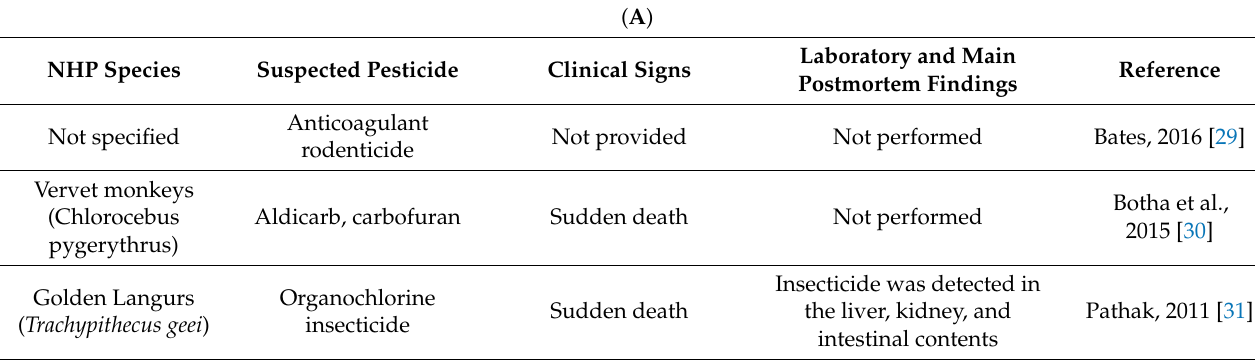
Table 3. ( A ) Summary of the reported cases of death in wild NHP due to acute pesticide poisoning on agricultural frontiers. ( B ) Summary of the reported birth defects and congenital anomalies in wild NHP due to suspected continual pesticide exposure on agricultural frontiers. * The clinical signs and main laboratory findings and pathology were often not performed and documented in the